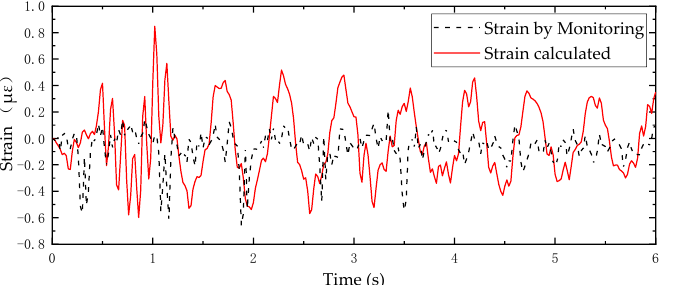
Figure 17. Comparison of dynamic strain between measurement and simulation results of DSS-06.